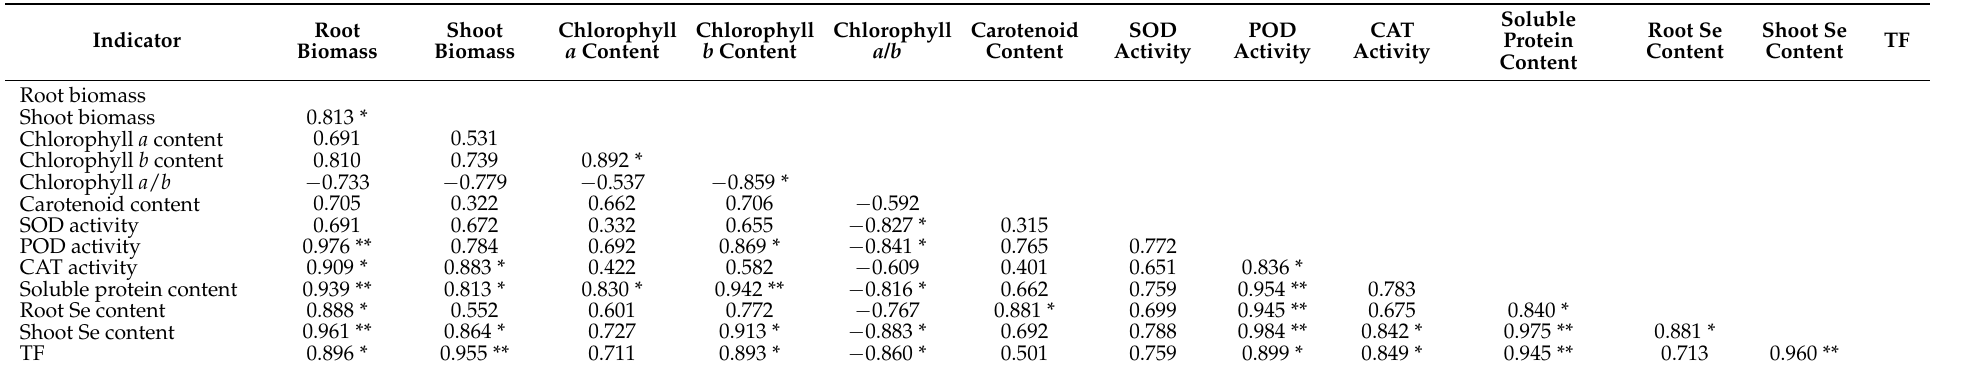
Table 4. Correlations among the different indicators of